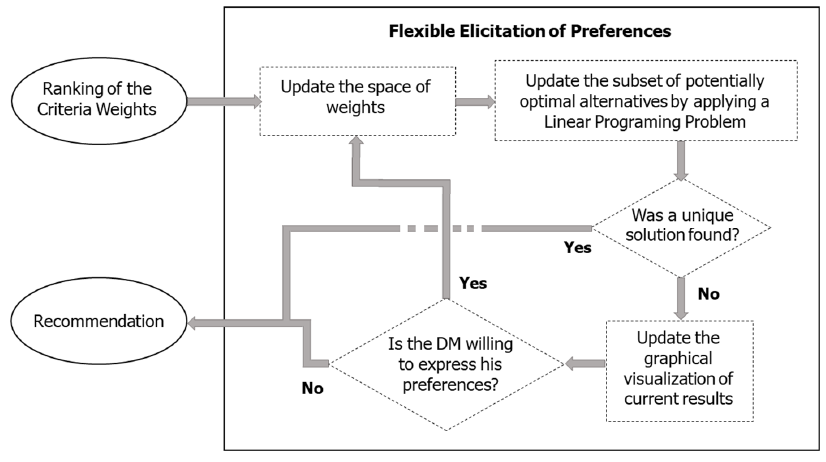
Fig. 3. Flexible elicitation process conducted at FITradeoff